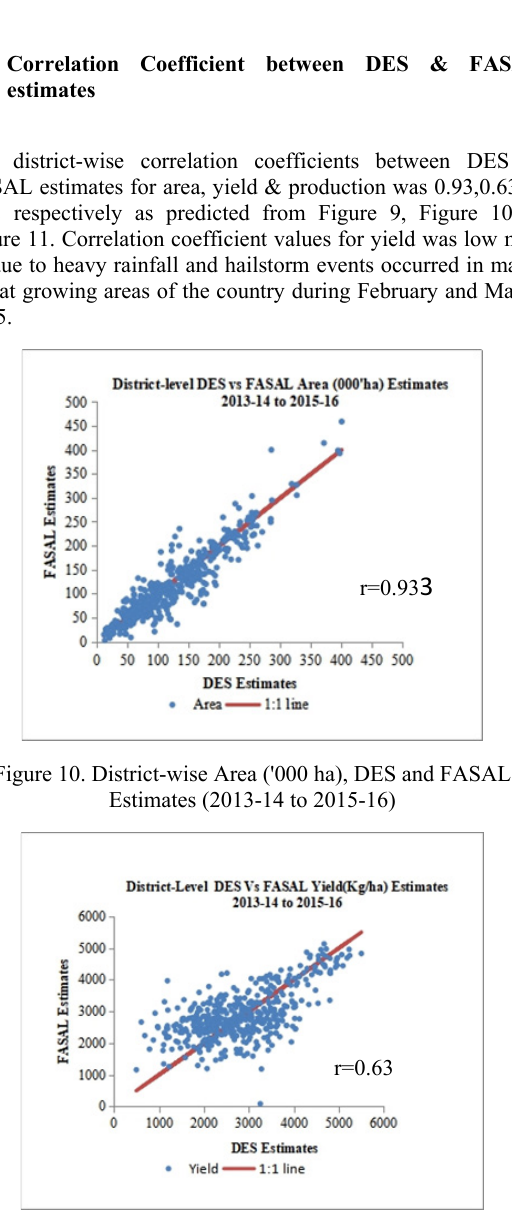
Figure 11. District-wise Yield (kg/ha), DES and FASAL Estimates (2013-14 to 2015-16)